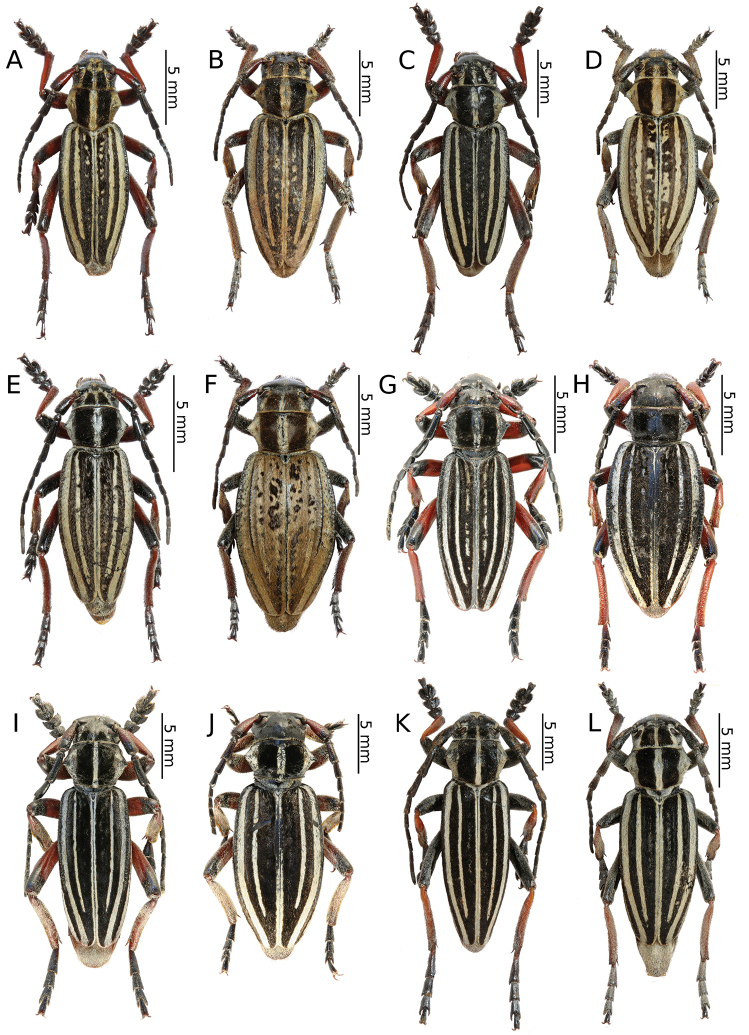
Photos of longhorn beetles specimens collected during the expedition to Kazakhstan in 2017: ADorcadionabsinthiumishkovi (male) BD.absinthiumishkovi (female) CDorcadionkapchagaicum (male) DD.kapchagaicum (female) EDorcadionnikolaevi (male) FD.nikolaevi (female) GDorcadionsuvorovikonyrolenum (male) HD.suvorovikonyrolenum (female) IDorcadiontianshanskiiradkevitshi (male) JD.tianshanskiiradkevitshi (female) KDorcadionunidiscale (male) LD.unidiscale (female).